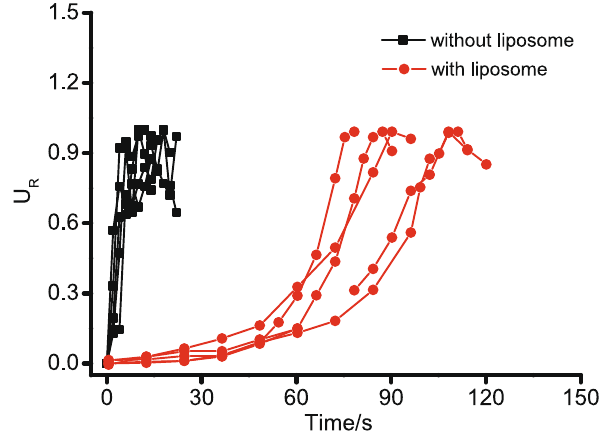
Fig. 5 Effect of liposome coating on droplet motion. Emulsion droplets were prepared with/without liposomes, and water was added to induce droplet motion. Five droplets with or without liposome were chosen from different trials for analysis. The ratio of droplet velocity at different time points to its maximum velocity was taken as relative velocity ( U R